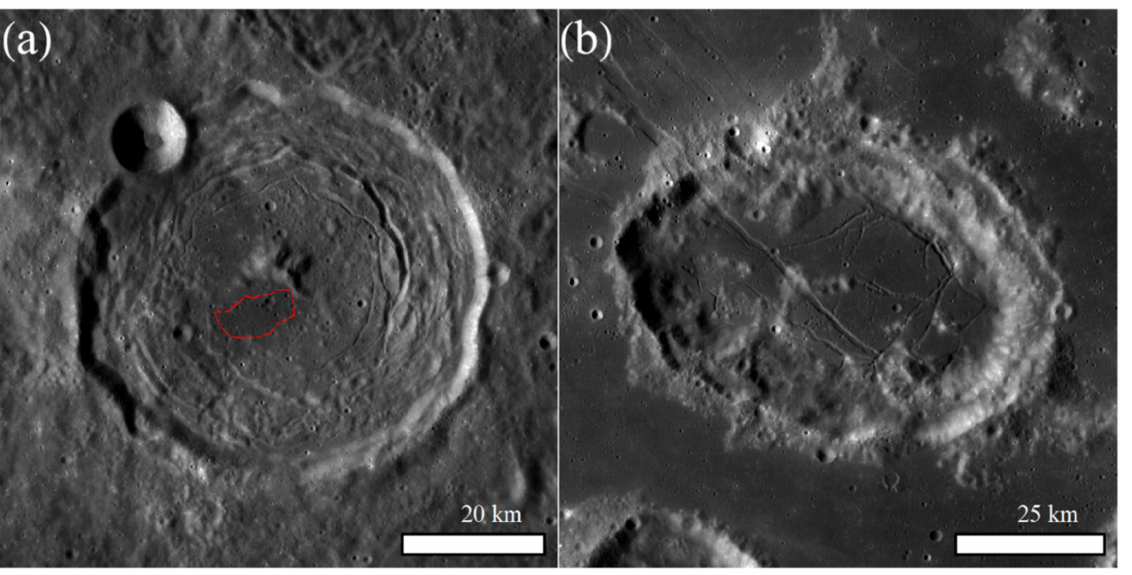
Figure 7. Floor-fractured craters, shown with WAC images. ( a ) Crater Taruntius (5.5 ◦ N, 46.5 ◦ E) with dark mantle pyroclastic deposits in the center (red dotted line); ( b ) Crater Goclenius (10.0 ◦ S, 45.0 ◦